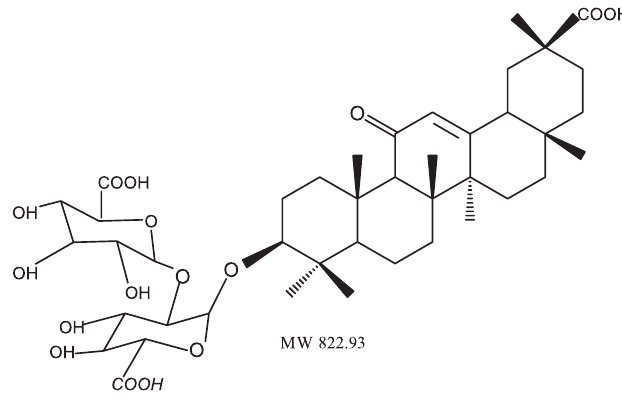
FIGURE 1- Structure of